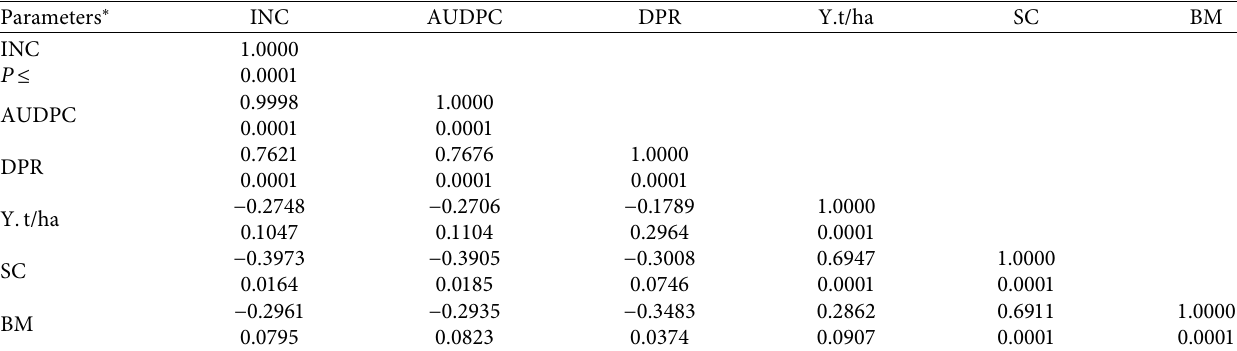
Table 5: Coefficient of correlation ( r ) between disease parameters and yield and some yield contributing